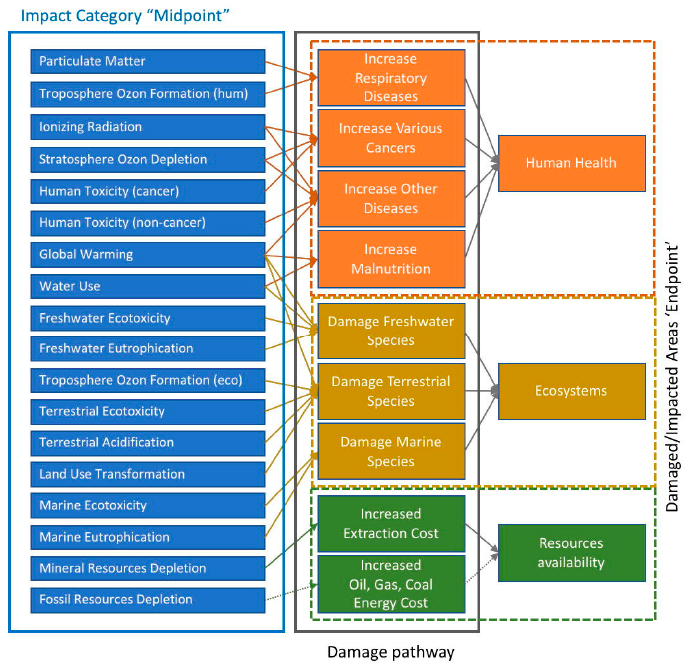
Figure 3. Representation of the relationships between impact categories (midpoint) and the areas of protection (endpoint) in Recipe 2016 (Adapted from Simapro database manual [29]).